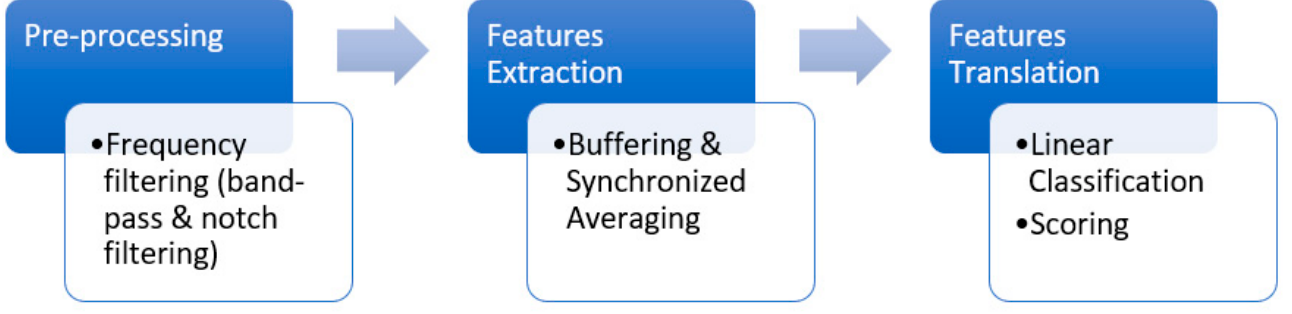
Figure 7. P300 signal ‐ processing steps implemented on the FPGA and the real ‐ time microprocessor.